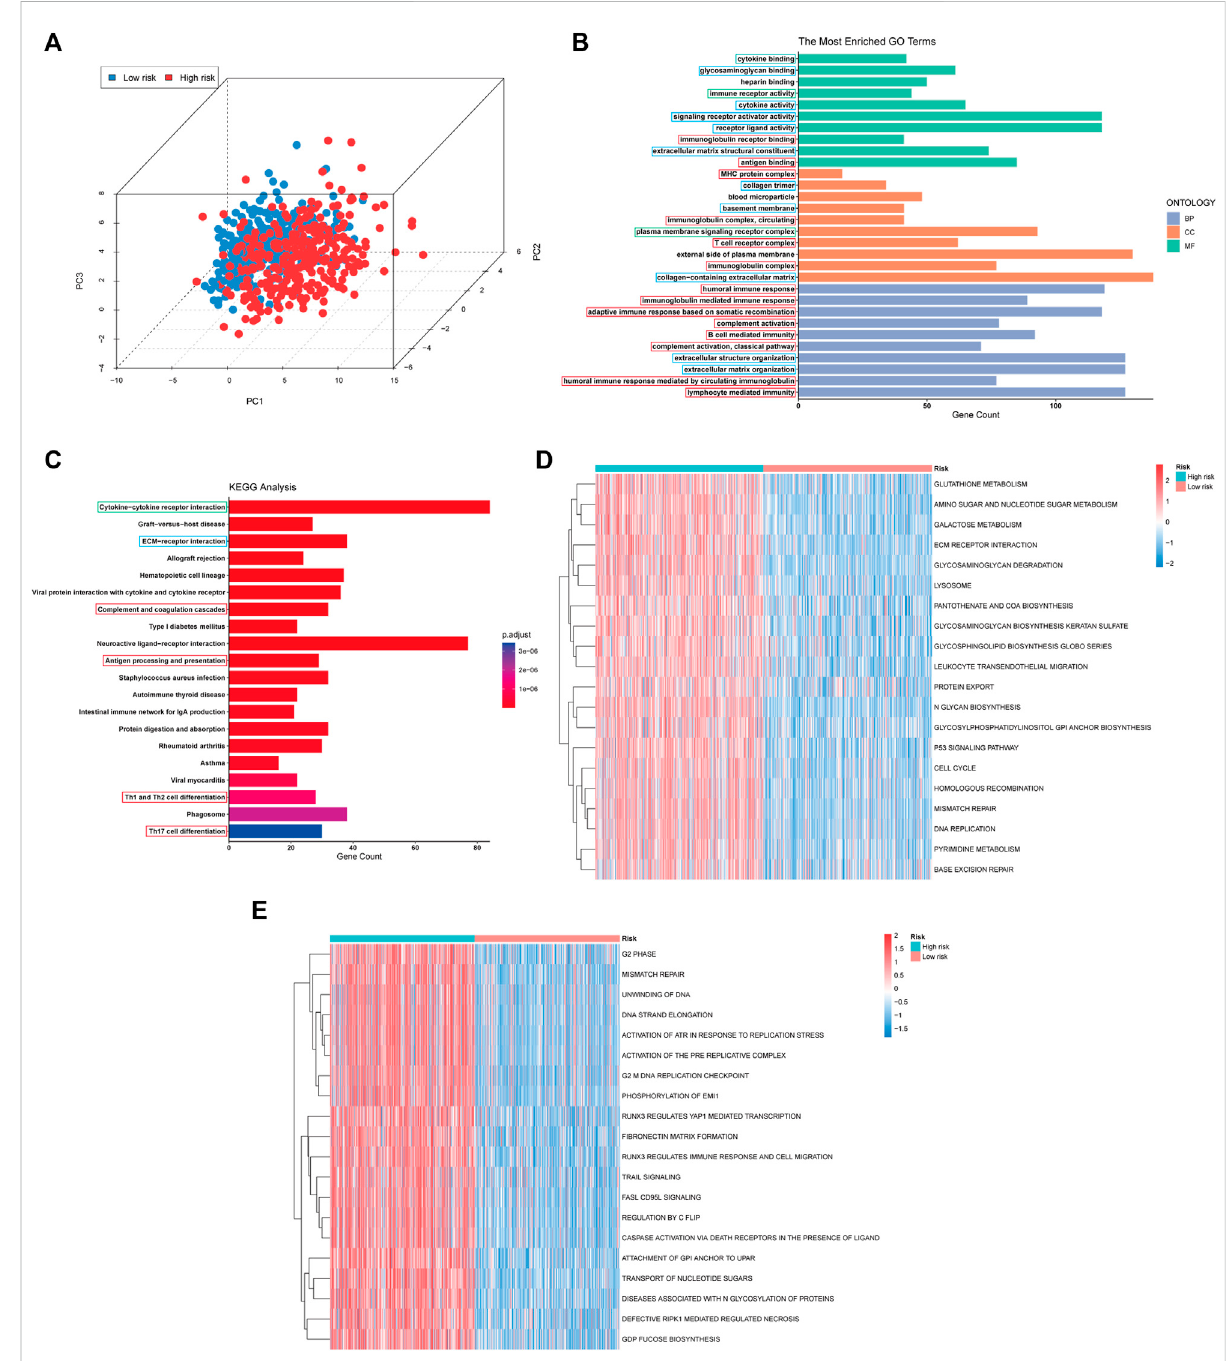
FIGURE 6 PCA plot and Functional enrichment analysis in TCGA cohort. (A) PCA showing the distribution differences between the high- and low-risk groups. (B,C) Results of GO and the KEGG analyses. The immune biological process, matrix-related pathway and intracellular communication pathwayswereboxedinred,blue,andgreen,respectively. (D,E) Thetop20differentialactivationpathwaysinKEGGandReactomegenesetbetween high and low-risk